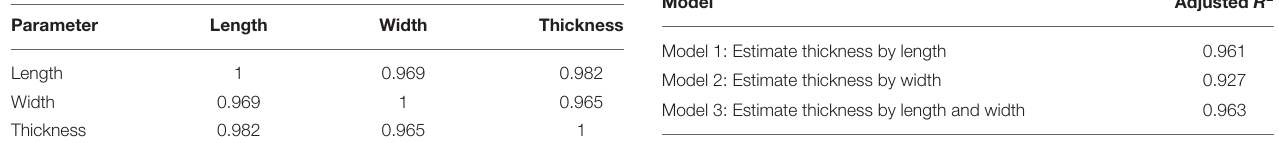
TABLE 1 | Pearson’s correlation coefficients (r) for length, width, and thickness, with significantly strong positive correlation for 22 examined ovaries collected from a slaughterhouse.